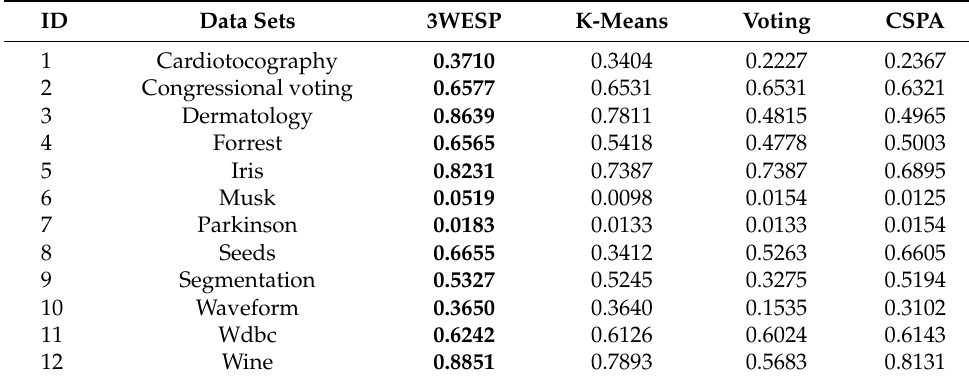
Table 2. Experimental results of AMI on UCI data sets.